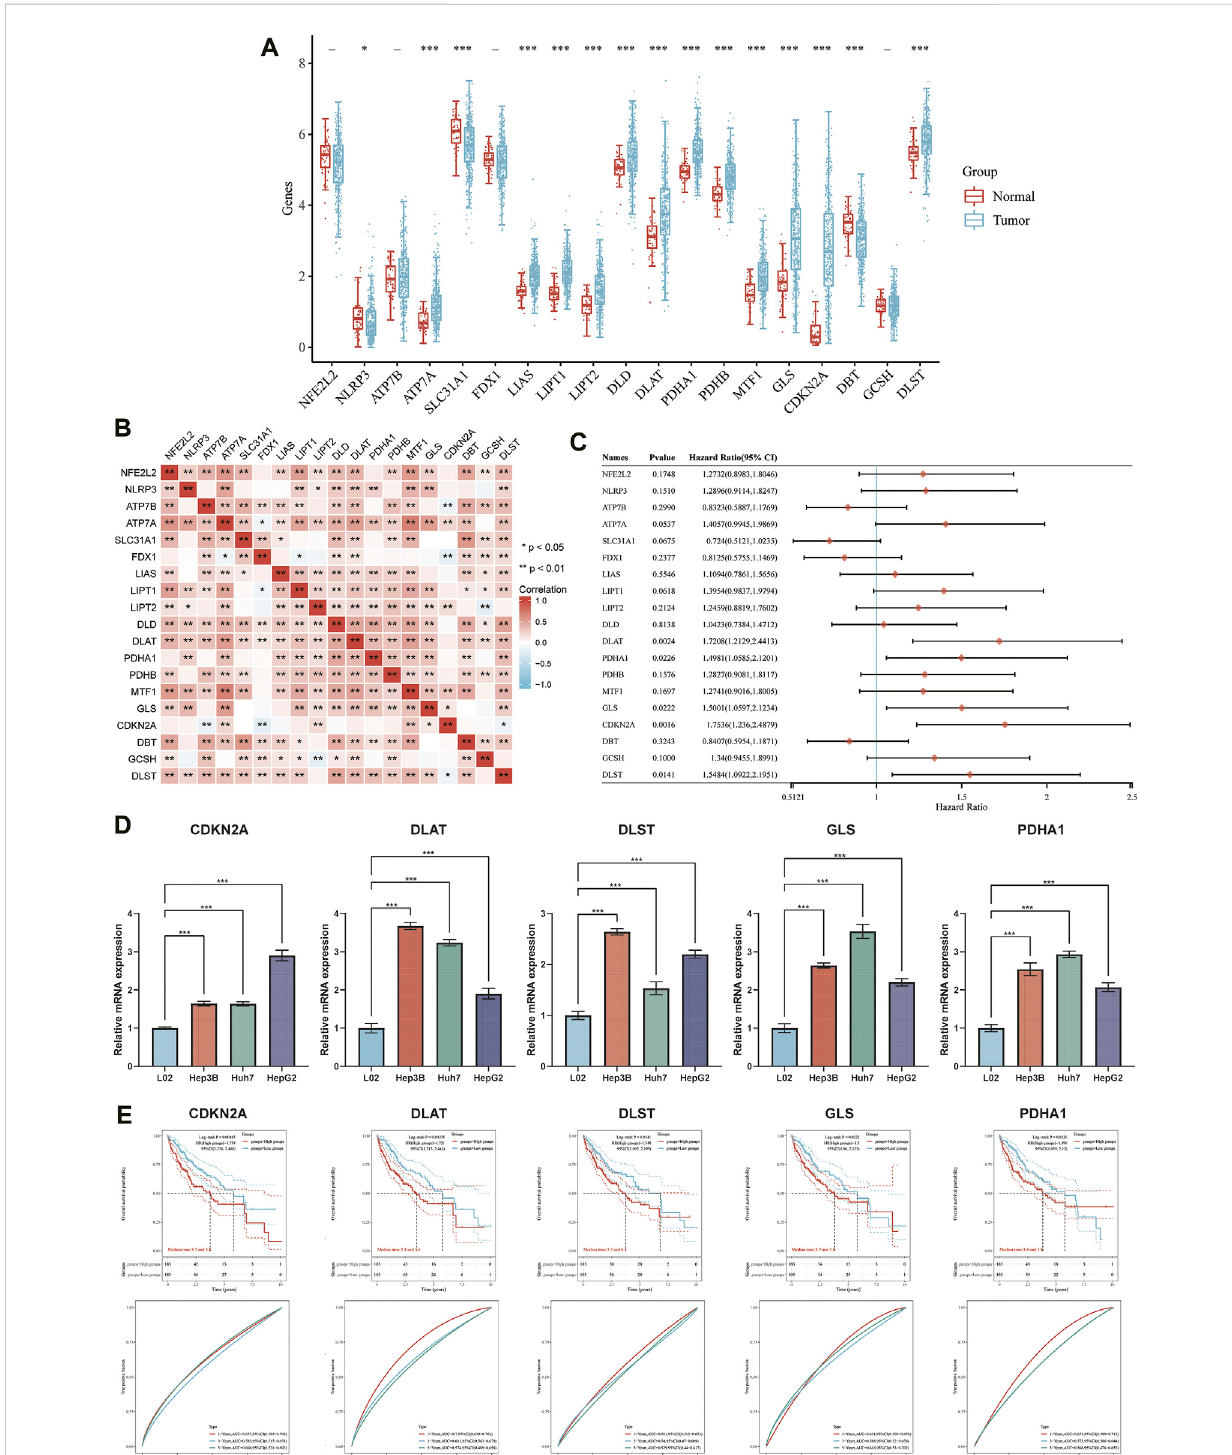
FIGURE 5 DEGs and prognostic models. (A) The expression of 19 CRGs in HCC and paracancerous tissues; the upper and lower ends of the box represent the interquartilerange ofthevalues.Thelineinthebox representsthemedian. (B) Correlation betweentheexpression ofcuproptosis regulators. (C) Analysis of fi ve prognostic CRGs from univariate Cox regression analysis plots. (D) mRNA expression of prognostic CRGs in HCC cell lines. (E) Prognostic value of fi ve CRGs ( CDKN2A, DLAT, DLST, GLS, and PDHA1 ) in HCC patients (OS curve of high/low expression